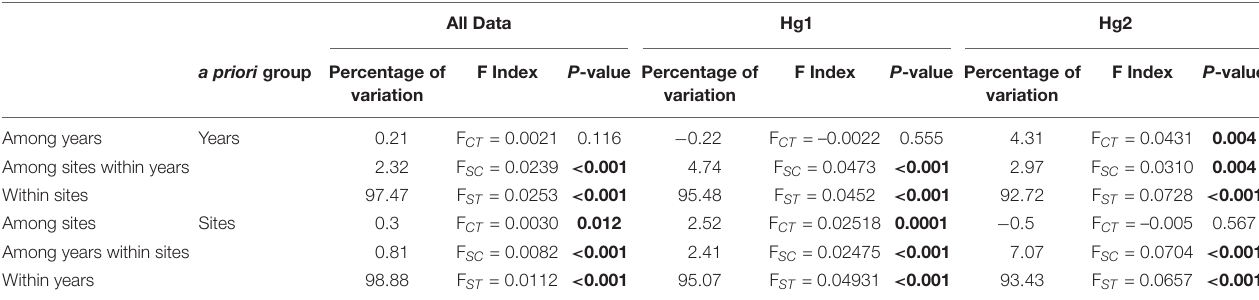
TABLE 2 | Analysis of molecular variance (AMOVA) depicting the percentage of variation explained among groups (years or site), among populations within groups, and within populations for the complete COI dataset, Hg1 and